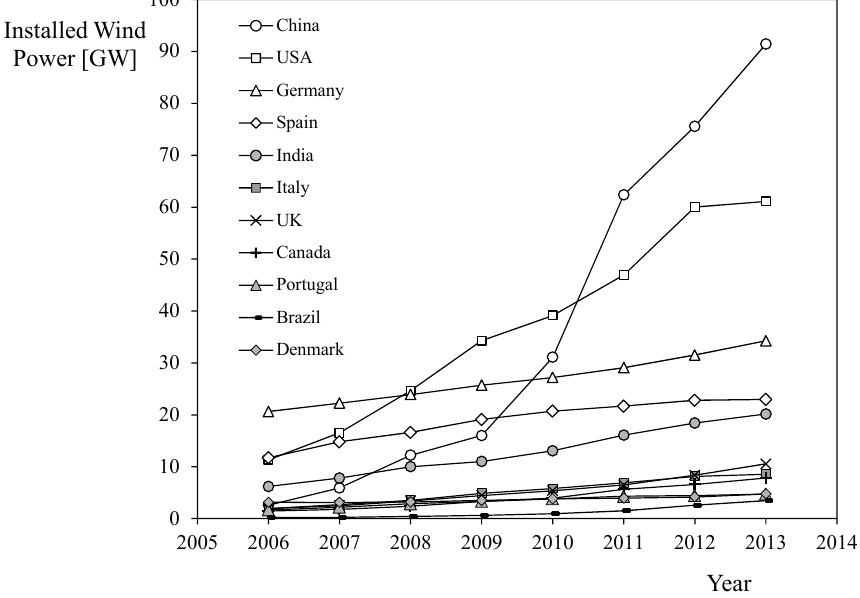
Figure 1. Installed wind power per country from 2006 to 2013. The graph includes data from some of the biggest producers in the world (sources: Global Wind Energy Council; US Energy Information